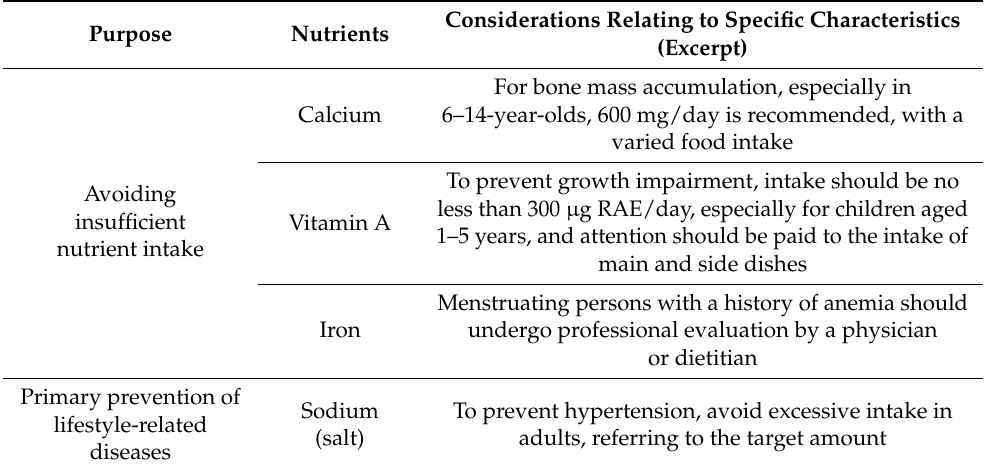
Table 6. Nutritional Reference Values for meal assessment—nutrients requiring consideration for specific groups.